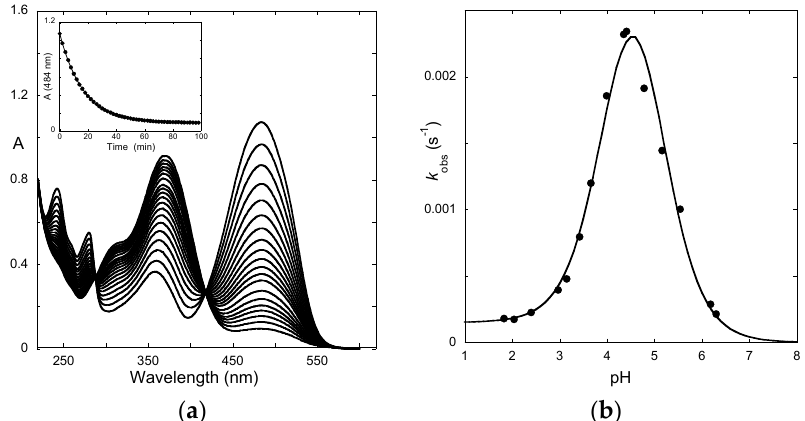
( b ) Figure 1. ( a ) Absorption spectra of compound 1 taken immediately (circa 1 min) after a direct pH jump; ( b ) the same at the equilibrium. The spectral variations are typical of anthocyanins and related compounds bearing hydroxyl substituents, showing isosbestic points and the absorption of the quinoidal base red shifted in comparison with flavylium cation. The measured p K a = 4.2 is the same of the analogous compound 7-hydroxy-4 ′ -methoxyflavylium [11]. In Figure 1b, the absorption spectra of the same solutions at the equilibrium are presented, Equation (5). In this case, the flavylium cation is involved in a single acid base equilibrium with CB (basically Ct and a minor contribution from A , Cc and B being negligible). The characteristic absorption spectrum of Ct appears blue shifted and the isosbestic points confirm that the system at the equilibrium is equivalent to a single acid base reaction with acid-base constant